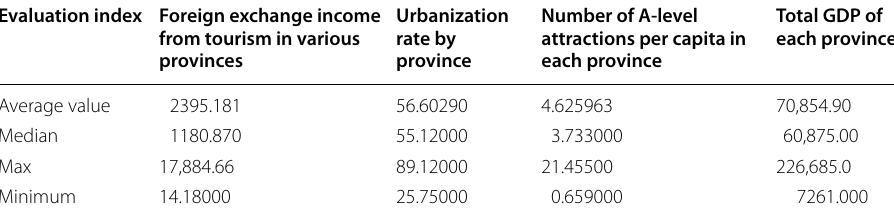
Table 3 Horizontal comparison of 2020 data in various provinces Evaluation index Foreign exchange income from tourism in various